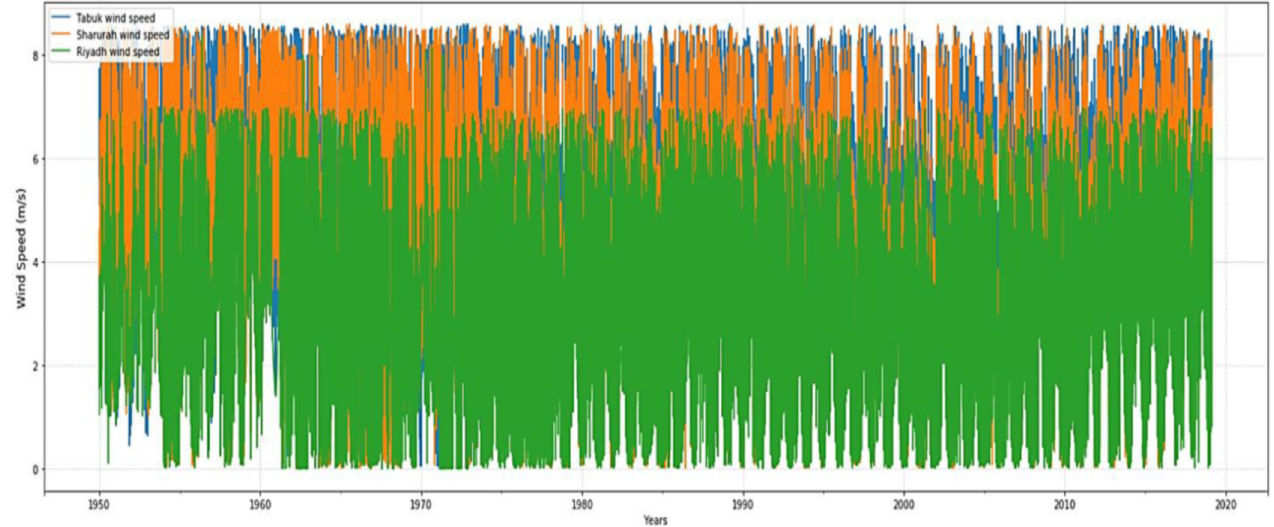
Fig. 3. The wind speed performance of the three regions [9]. The lowest wind speed is 0m/s and the highest is 8 ms (cid:1) 1 .